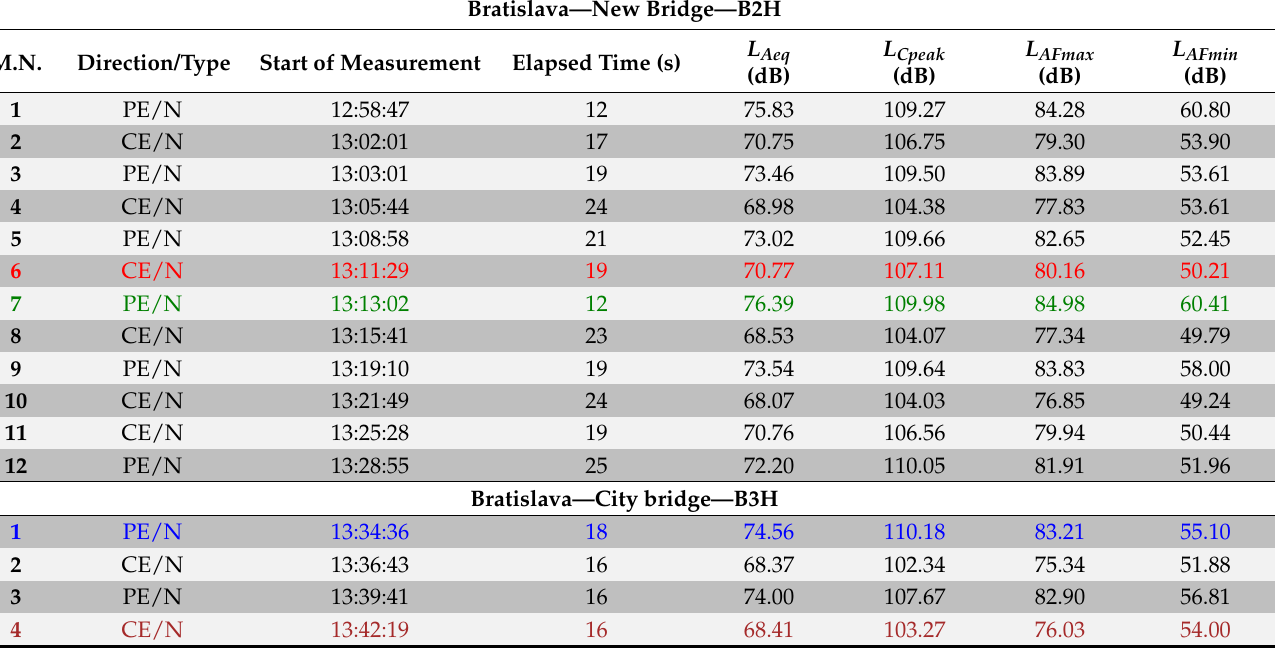
Table 6. Time history of measurements and overview of values of measured quantities of the whole record at B2H and B3H . Bratislava—New